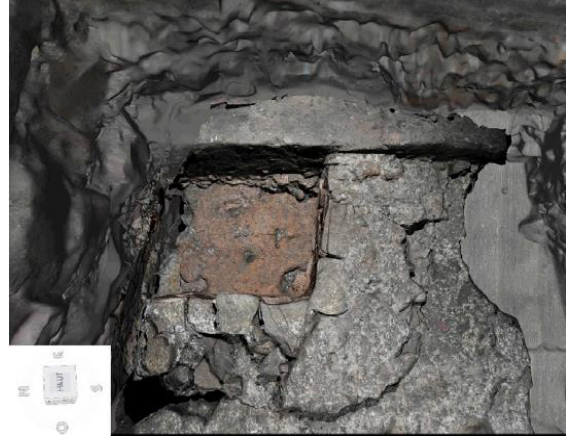
Figure 9. Focus on the 3D textured model showing the part